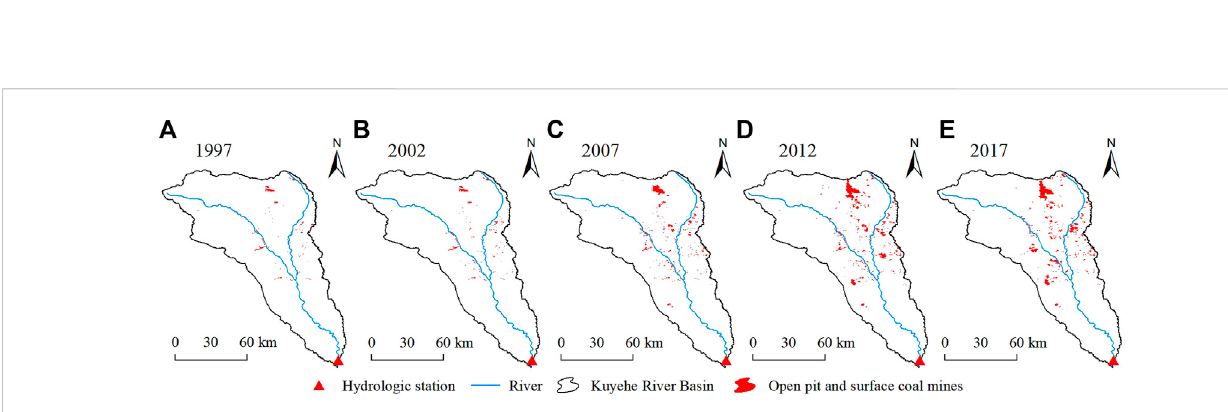
Frontiers in Earth